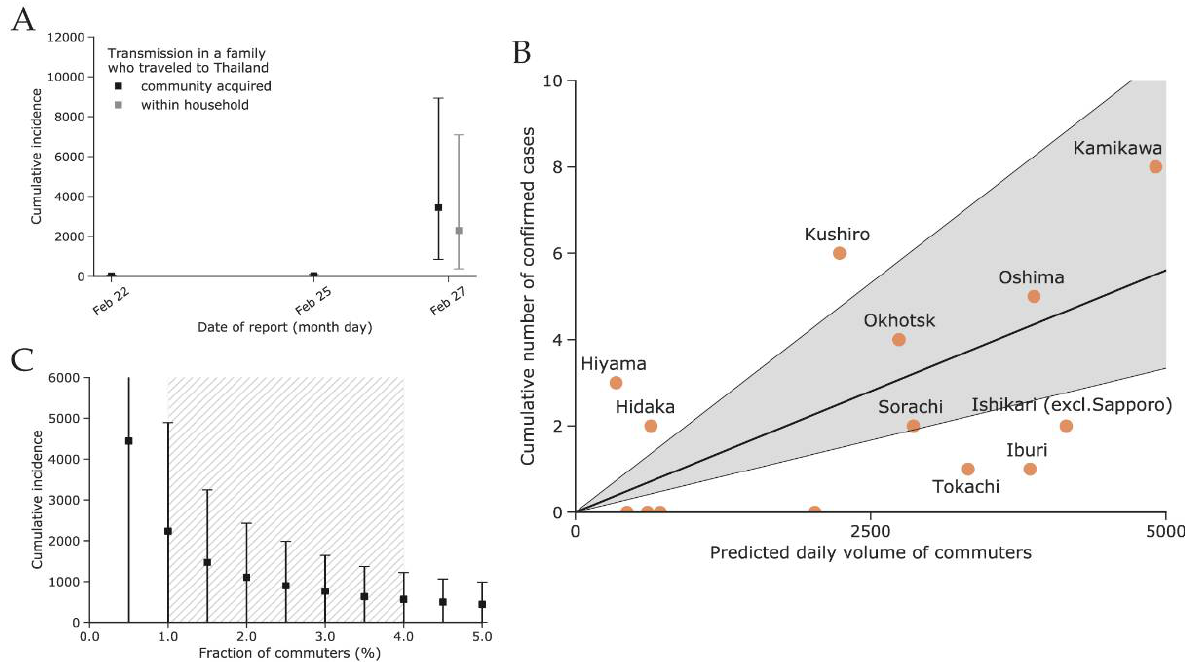
Figure 3. ( A ) Estimated cumulative incidence of coronavirus disease 2019 (COVID-2019) in Hokkaido using the count of imported cases either internationally or domestically outbound from Hokkaido (method (i)). ( B ) Modeled daily volume of commuters and observed incidence of COVID-19 by subprefecture of diagnosis. The four subprefectures with zero case counts are Rumoi, Soya, Nemuro, and Shiribeshi (from left to right). ( C ) Estimated cumulative incidence in Sapporo as of 29 February with a varying fraction of commuters (method (ii)). The plausible range between 0.5% and 4% is indicated by the hatched grey area. The square points in ( A , C ) indicate the estimated mean, whereas the error bars indicate the 95% confidence intervals.